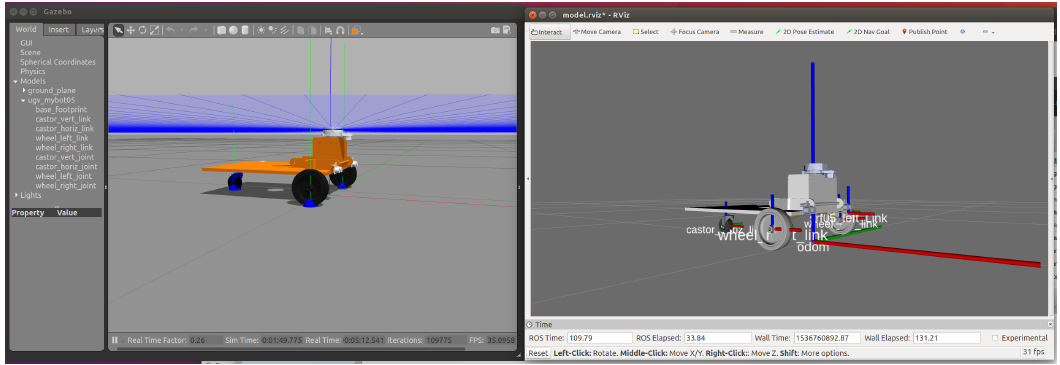
Figure 4. The wheeled mobile robot in the Gazebo